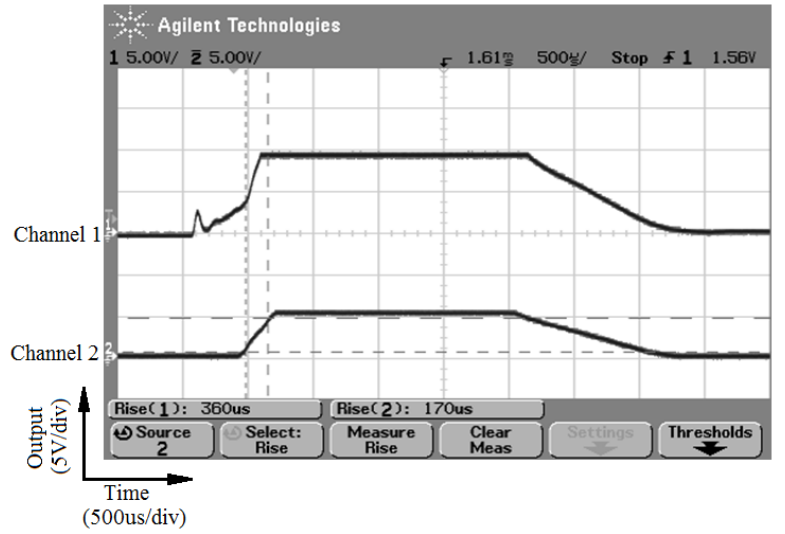
Figure 5. Tactel response to a force pulse. Channel 1 shows the output from the probe silicon force sensor and Cannel 2 shows the output from the tactel.